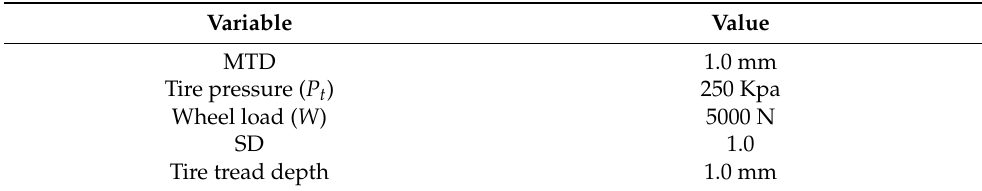
Table 5. Variables for hydroplaning speed